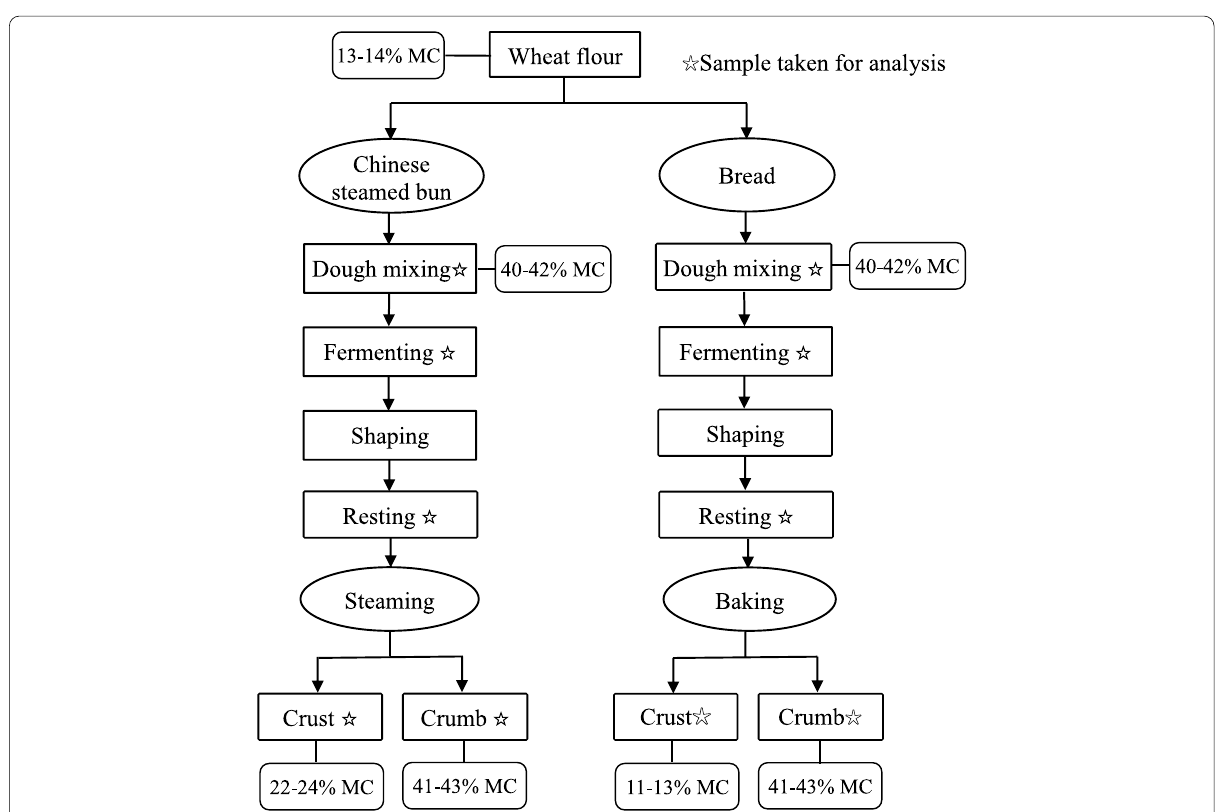
Fig. 1 Processing steps of Chinese steamed bun and bread production with sampling